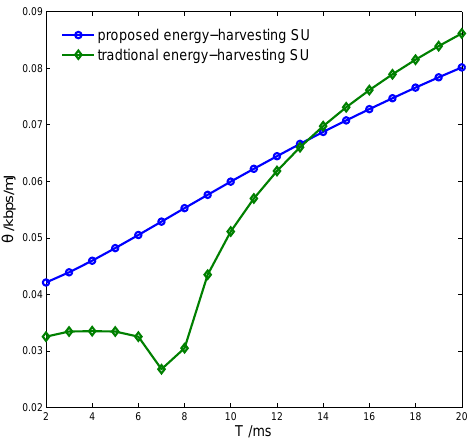
Figure 10. Energy-harvesting efficiency versus frame duration. SU: secondary user.